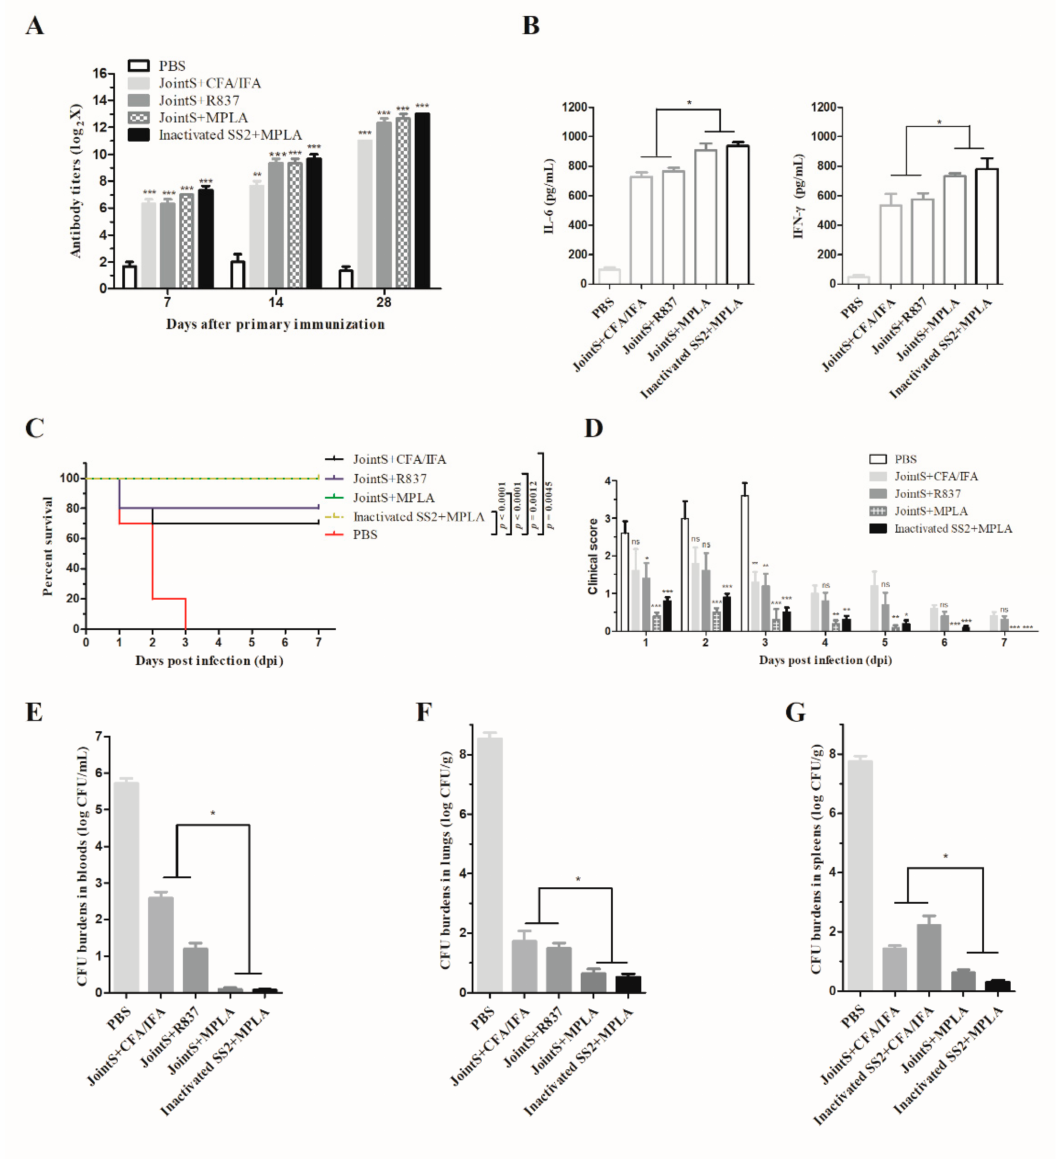
Figure 3. MPLA combined with JointS to prevent S. suis infection in mice antibody titer ( A ), cytokine levels ( B ), immune protection rates ( C ), clinical score ( D ), and colony forming unit (CFU) burdens in the blood or tissues ( E – G ) in the differently vaccinated groups after challenge by HA9801. The mice were immunized by JointS protein formulated with Freund’s adjuvant (JointS + CFA/IFA), R837 (JointS + R837), or MPLA (JointS + MPLA). The mice immunized by inactivated SS2 (HA9801) strains formulated with MPLA were termed inactivated SS2 + MPLA. The PBS-immunized mice served as the control group. After 28 days, a lethal dose (5 × 10 8 CFU/mouse) of SS2 was injected into the abdominal cavities of the mice. Survival rates and clinical signs were monitored for seven days post-infection. In ( A ), Kruskal Wallis test followed by Dunn’s post-hoc test showed that the antibody titers in the immunized mice were significantly higher than in the non-immunized mice. In ( B ), an unpaired Student’s t -test showed that the cytokine levels in the groups administered antigens formulated with MPLA were significantly higher than in the groups administered JointS formulated with Freund’s adjuvant or R837. In ( C ), survival rates were analyzed by a log-rank (Mantel–Cox) test. In ( D ), Kruskal Wallis test followed by Dunn’s post-hoc test showed that the clinical score in the immunized mice were significantly lower than in the non-immunized mice. In ( E – G ), an unpaired Student’s t -test showed that the CFU burdens in the groups administered antigens formulated with MPLA were significantly lower than in the groups administered JointS formulated with Freund’s adjuvant or R837. Samples collected from each mouse were tested in triplicate. *** p < 0.001, ** p < 0.01, * p < 0.05, and ns ( p > 0.05). The error bars represent